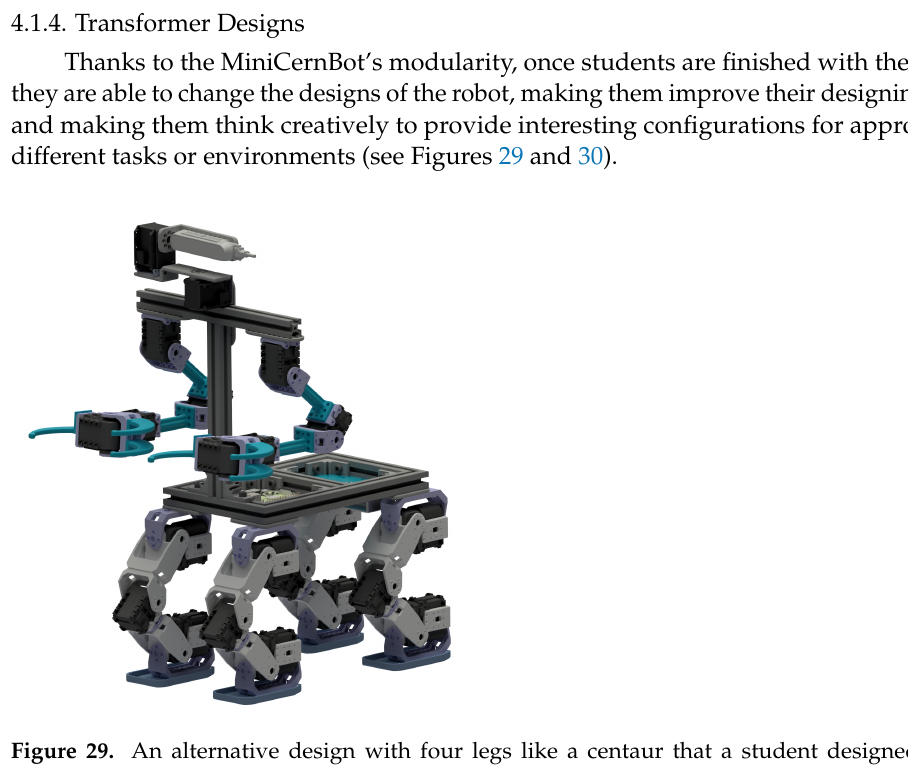
Figure 28. Exoskeleton designed by the student in order to remotely control the robot arm.